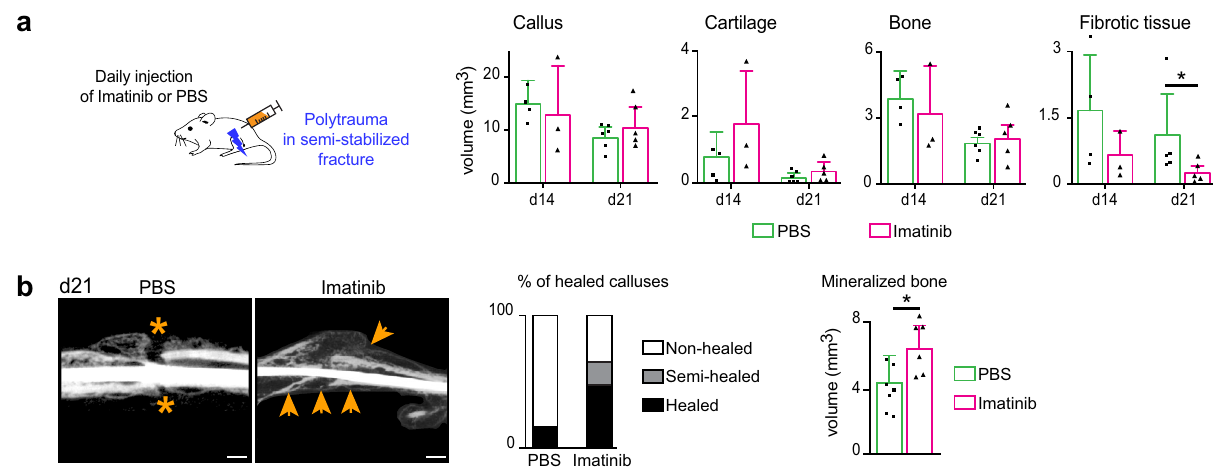
Fig. 7 Imatinib decreases callus fi brosis and improves fracture healing after polytrauma. a Daily injection of Imatinib ® (50 mg/kg/day) or vehicle (PBS) after polytrauma in semi-stabilized tibial fracture. Histomorphometric analyses of total callus, cartilage, bone, and fi brotic tissue volumes of PBS-treated and Imatinib-treated mice at days 14 and 21 (d14 PBS-treated n = 4, d14 Imatinib-treated n = 3, d21 PBS-treated n = 6, d21 Imatinib-treated n = 5) (Exact p - value calculated with two-sided Mann – Whitney test: Fibrotic tissue d21: 0.0317). b Representative micro-CT images of fracture calluses in PBS-treated and Imatinib-treated mice. Absence of bone bridging in PBS-treated mice (orange asterix) and presence of bone bridging in Imatinib-treated mice (orange arrow). Quanti fi cation of healed and non-healed calluses at d21 post-treatment (PBS-treated n = 7, Imatinib-treated n = 6). Quanti fi cation of mineralized bone volume (right) (PBS-treated n = 7, Imatinib-treated n = 6) (Exact p -value using two-sided Mann – Whitney test: Mineralized bone d21: 0.0303). b : Representative images of three independent experiments. scale bars: 1 mm. All data represent mean ±